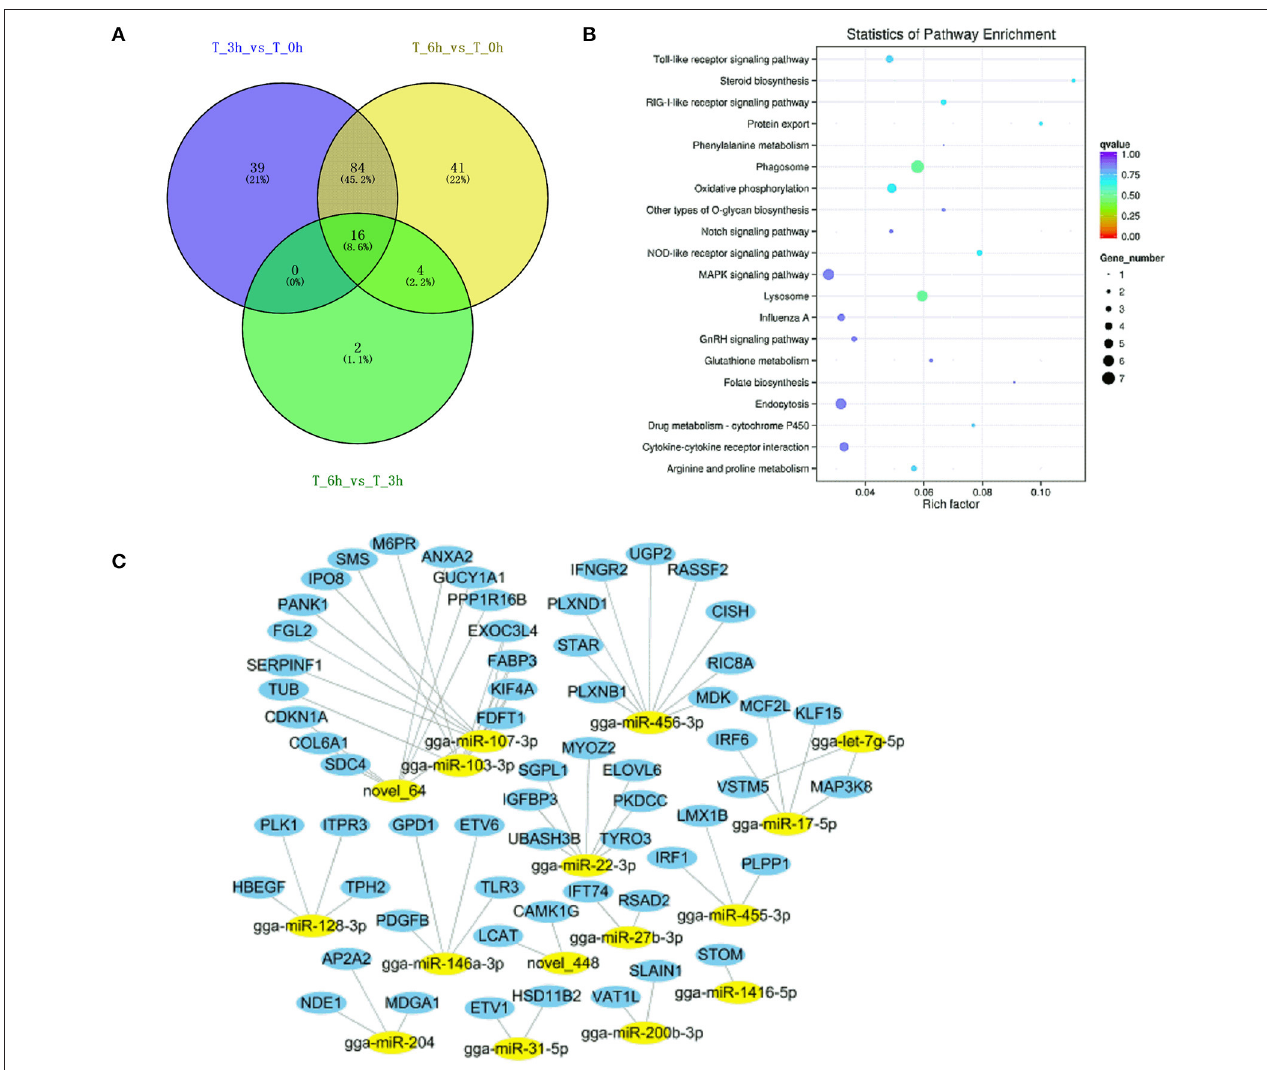
FIGURE 12 | Analysis of targeted genes with significant differential expression miRNAs of lncRNA-miRNA-mRNA and circRNA-miRNA-mRNA regulatory networks. (A) DE-miRNAs were analyzed between 3 vs. 0, 6 vs. 0, and 6 vs. 3h infection groups. (B) KEGG analysis of 16 DE-miRNAs targeted genes. (C) The regulatory network of 16 DE-miRNAs and targeted